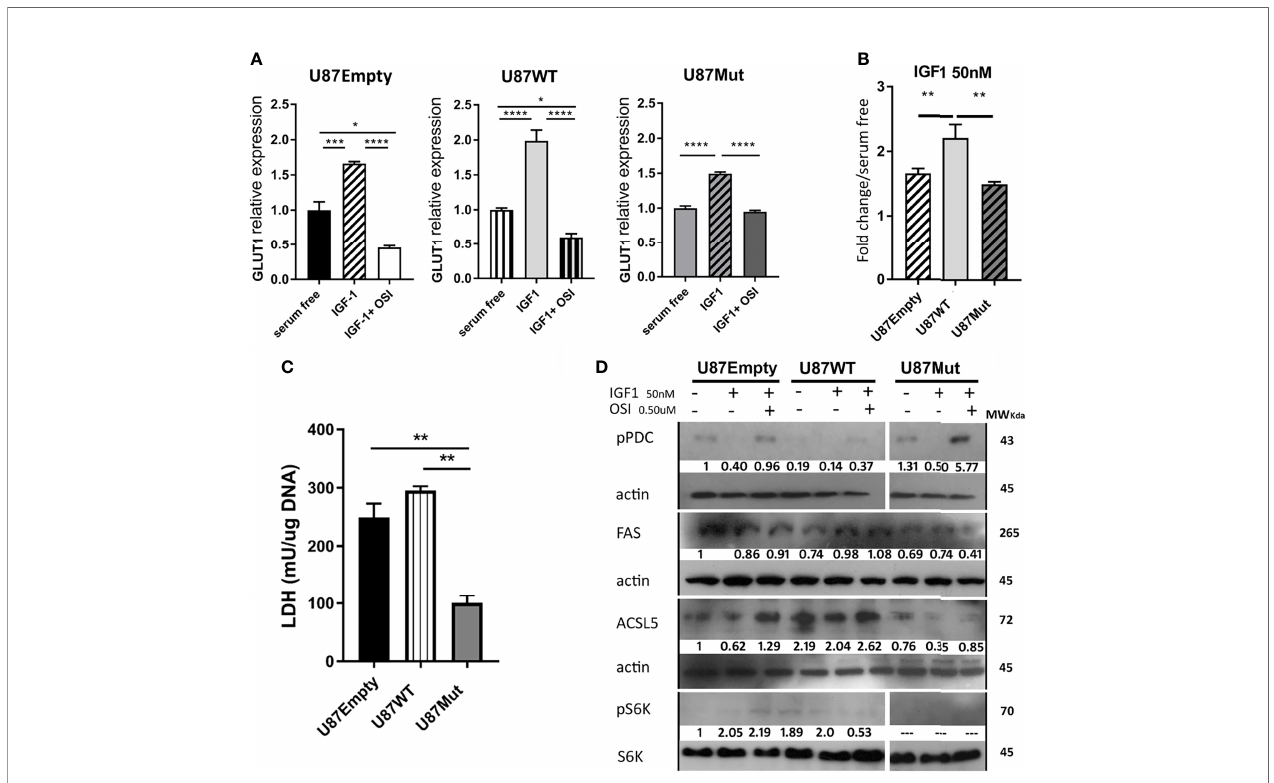
FIGURE 3 | Effects of IGF1R localization over cell metabolism. (A) U87Empty, U87WT, and U87Mut cells were cultured 24 h in serum-free medium or with 50-nM IGF1 stimulation (IGF1). To test the speci fi city of the response, pre-incubation (1 h) with 0.5 m M OSI906 was also performed (IGF1+ OSI). (A, B) GLUT1 mRNA expression was calculated by rqPCR by the relative quantitation method. (A) Values are presented as fold change compared to control conditions (serum-free). (B) IGF1 stimuli comparison between cell lines. The results are presented as fold change due to IGF1 stimulation over basal conditions (serum-free). Values are expressed as mean ± SD of three independent experiments performed in triplicates (* p < 0.05, ** p < 0.005, *** p < 0.001, **** p < 0.0001, ANOVA, Tukey ’ s post- test). (C) LDH enzyme activity was measured and normalized to DNA content (mg). The results are expressed as mean ± SD of three independent experiments (** p < 0.005, ANOVA, Tukey ’ s post-test). (D) Representative western blotting ( n = 3) for U87Empty, U87WT, and U87Mut cell protein extracts. The membranes were blotted with anti-pPDC (line 1), anti-FAS (line 3), anti-ACSL5 (line 5), and anti-pS6K (line 7). Each blot was stripped and reprobed with anti- b actin (lines 2, 4, and 6) or antitotal-S6K (line 8). The relative quanti fi cation of the bands is shown under each